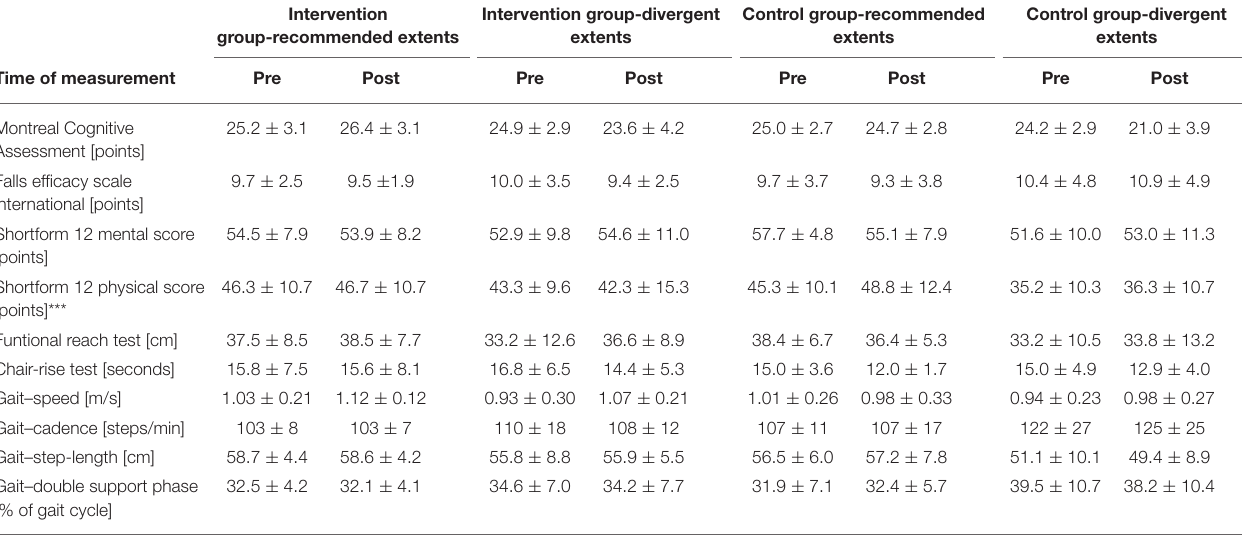
TABLE 3 | Effect estimator values at baseline and post-intervention for each sub-cohort. Intervention Intervention group-divergent Control group-recommended group-recommended extents extents extents